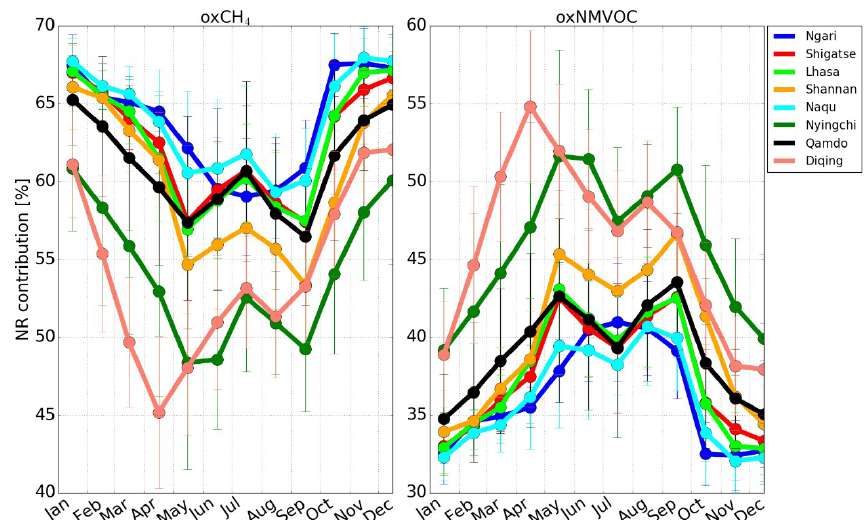
Figure 10. Monthly mean contributions of CH 4 and NMVOC oxidations to the total oxidation-associated CO transport to the HTP. The vertical error bar represents the 1 σ standard variation within that month. See Table 2 for a description of each